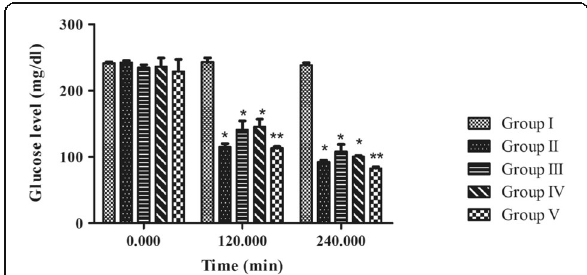
Fig. 4 Effect of ethanolic extract of C. azarolus var. eu- azarolus leaves and 3 β -O acetyl ursolic acid on glucose level in diabetic mice test, * p < 0.01, ** p < 0.001. Group I is the control, group II: positive control and received glibenclamide, group III and IV were given the plant extract at doses of 250 and 500 mg/kg respectively, and group V was treated with the isolated compound